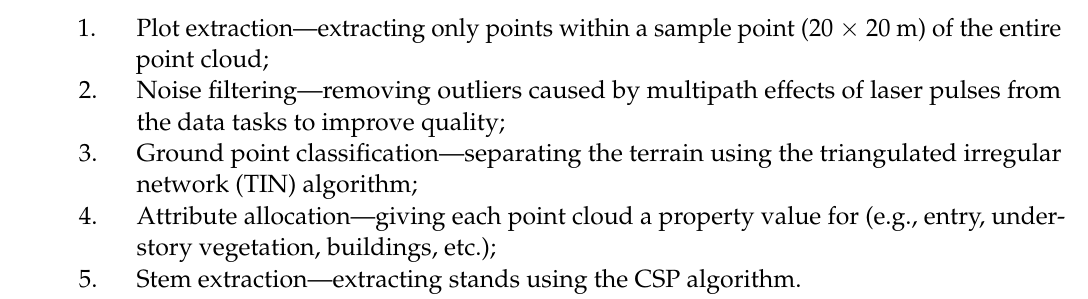
Table 4. Survey method categorization by device.